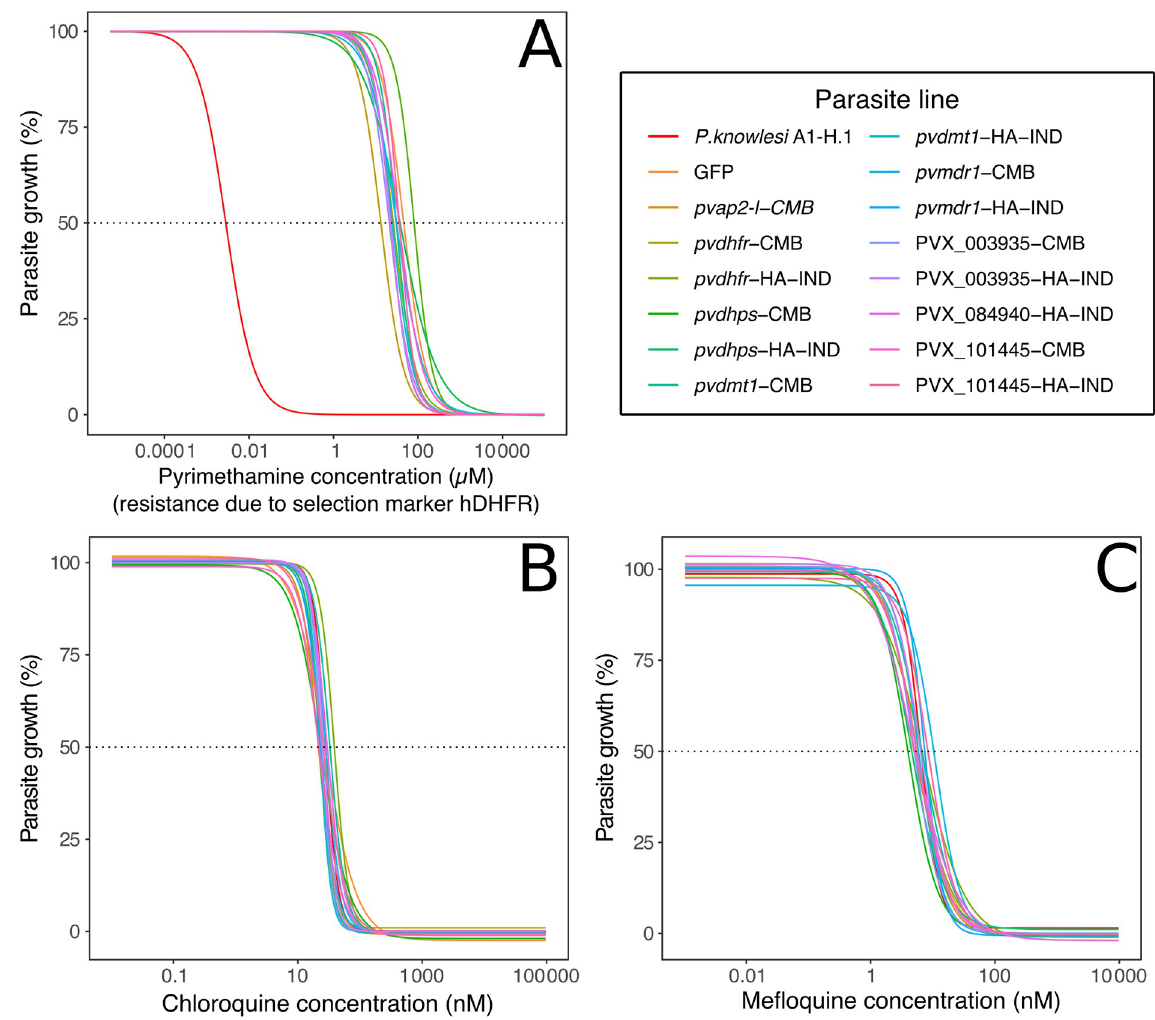
Fig 4. Transfected P. knowlesi lines show no evidence of a change in sensitivity to chloroquine or mefloquine but are resistant to pyrimethamine due to the expression of hDHFR. (A) Pyrimethamine dose-response curves. (B) Chloroquine dose-response curves. (C) Mefloquine dose-response